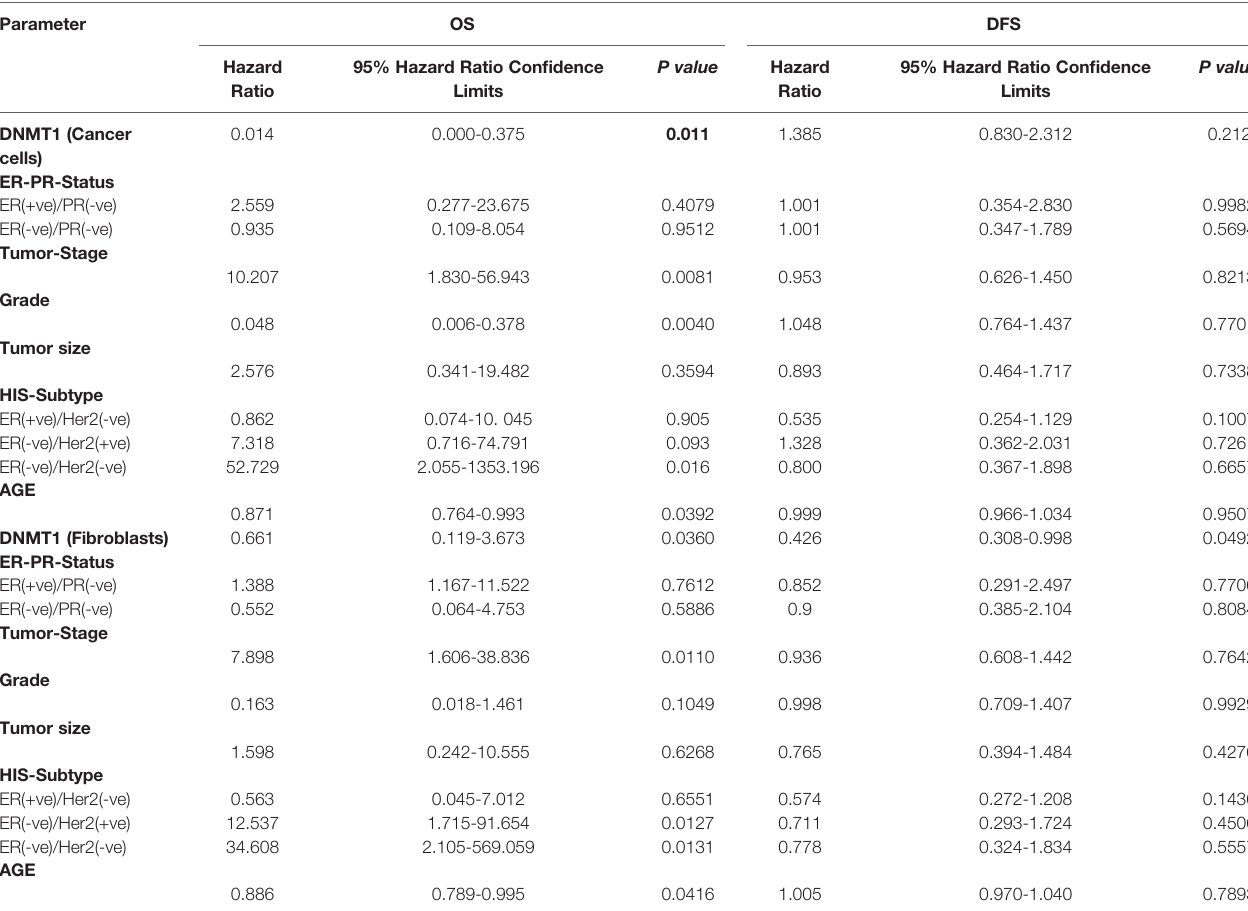
TABLE 4 | Multivariate Cox Regression analysis on 5-year overall and disease-free survival.